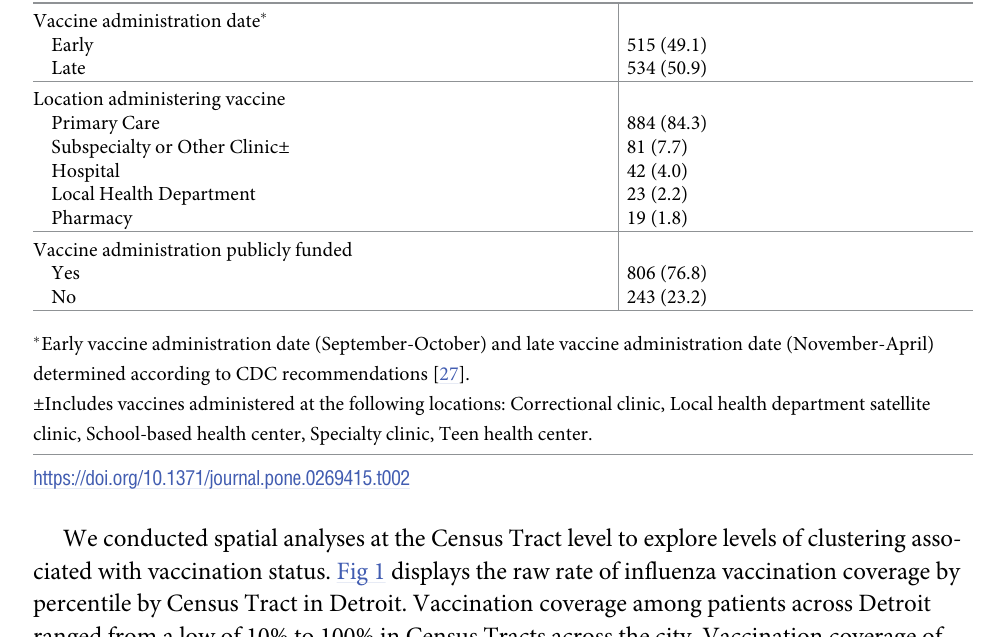
Table 2. Vaccine administration characteristics for vaccinated children, n (%) (n =